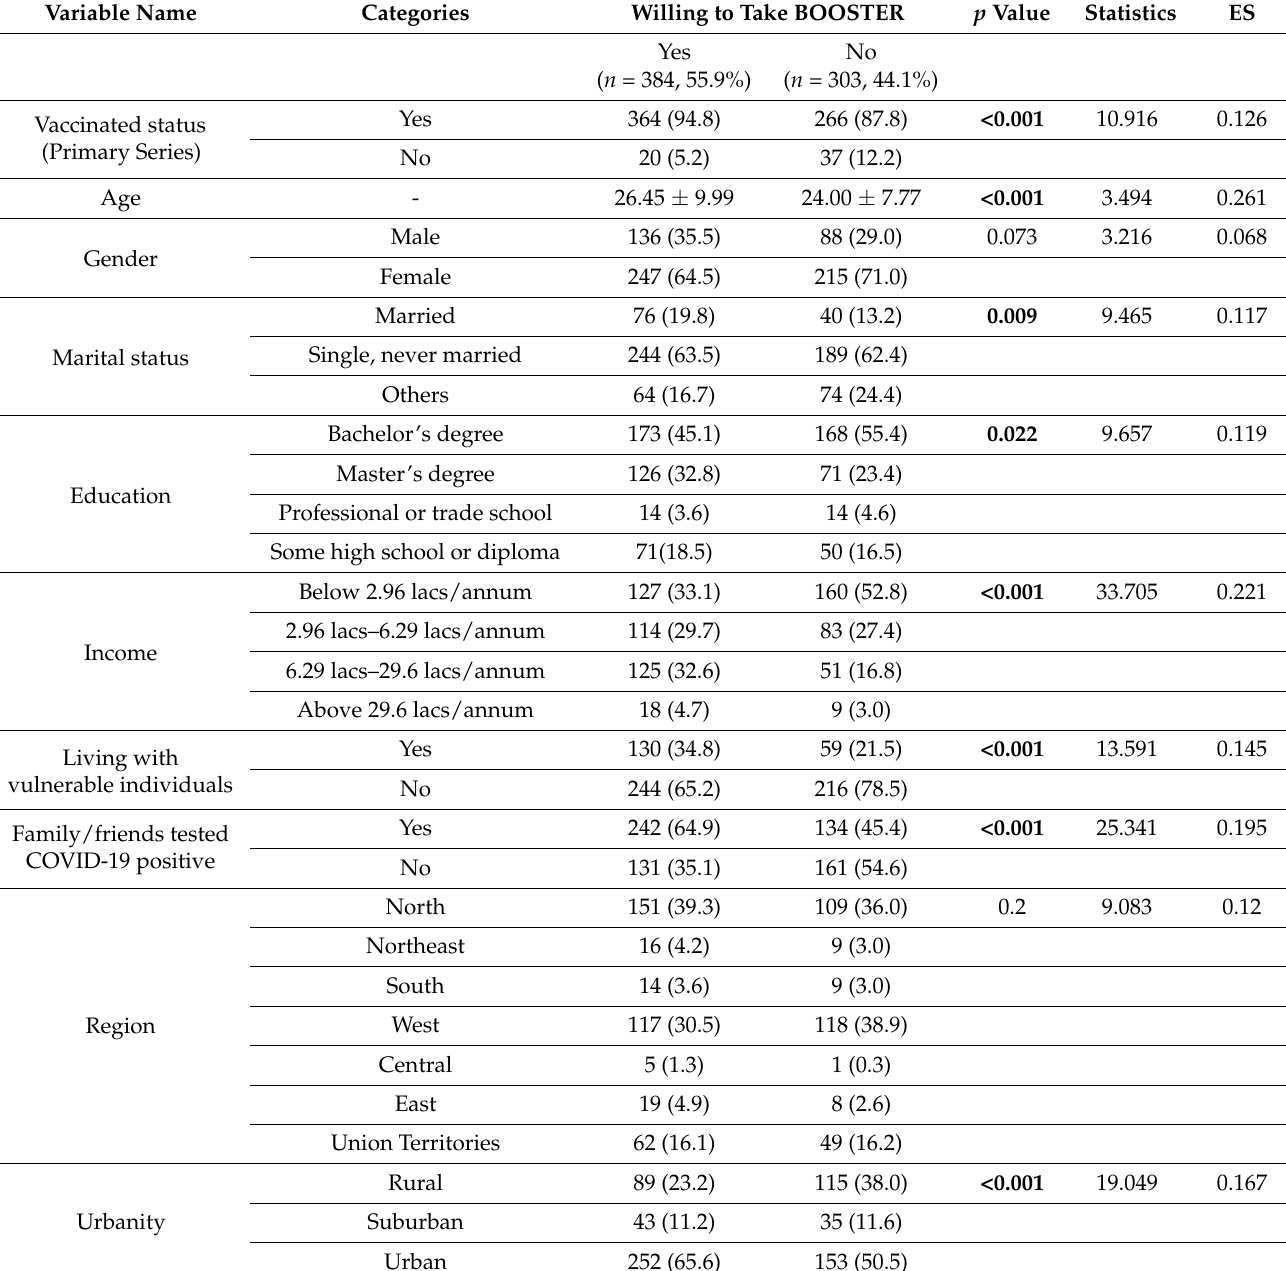
Table 2. Bivariate comparison of Booster Dose acceptability by sample characteristics ( n =